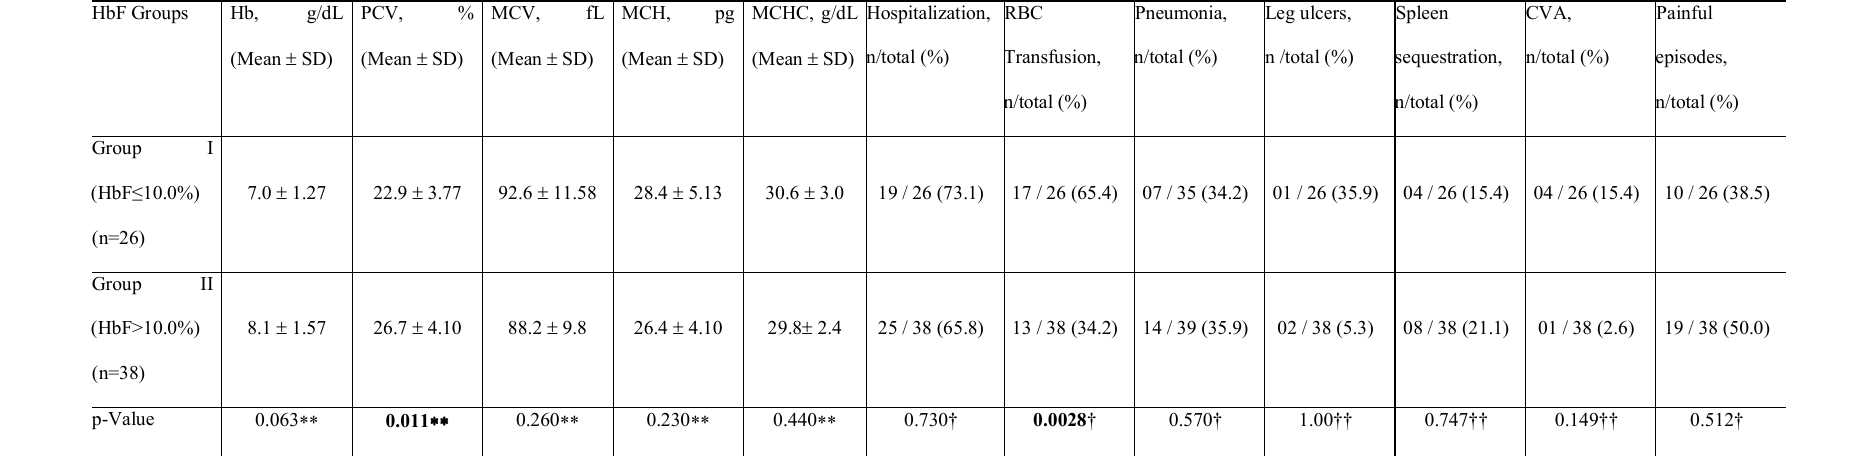
Hematologic and clinical characteristics among sickle cell anemia patients from Bahia – Brazil, with age ≤ 18.0 years and HbF levels ≤10.0 and > 10.0%. Significant results of statistical tests (at the 5% level) are shown in bold face